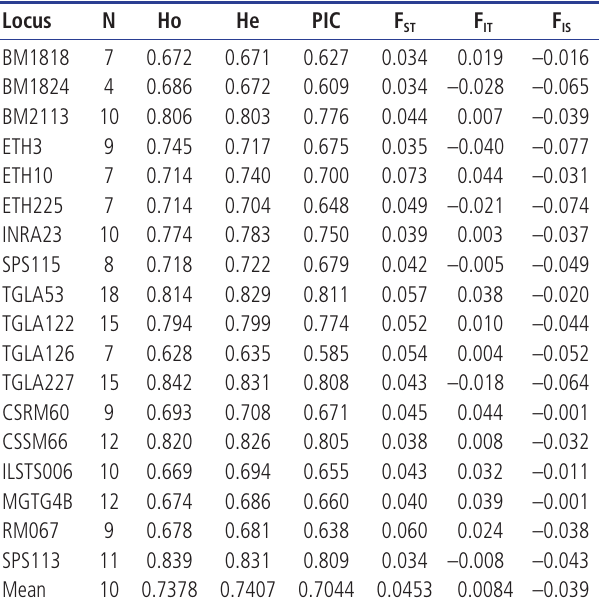
Table 2. Number of alleles (N), observed and expected heterozygosity (Ho and He), polymorphism information content (PIC), and F-statistics values of 18 microsatellite markers among 16 Limousin cattle breeds